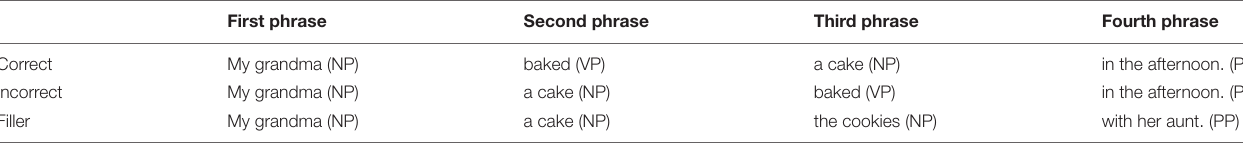
TABLE 1 | Examples of the three types of sentences presented during the simultaneous fNIRS–ERP measurements and used for grammar